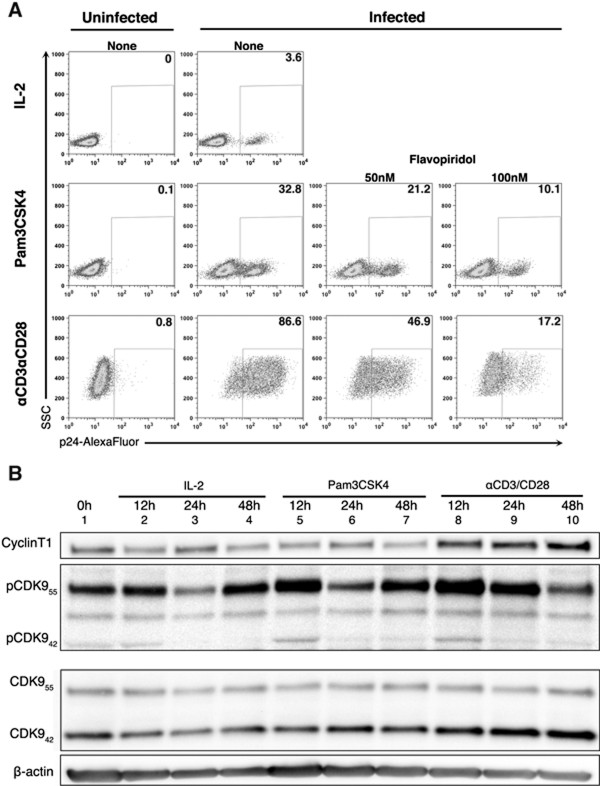
Pam3CSK4 induces viral reactivation in a Tat-dependent manner. (A) Cultured TCM cells were infected with wild-type DHIV and treated with Pam3CSK4 or stimulated with αCD3/αCD28 in the presence of 50 nM and 100 nM of Flavopiridol and assessed for intracellular p24 Gag expression by flow cytometry. Data is representative of two donors. (B) Culture TCM were either left unstimulated (0 h) or stimulated with IL-2, Pam3CSK4 and αCD3/αCD28 for 12 h, 24 h or 48 h. Whole cell extracts were isolated as indicated in the experimental procedure section. Proteins were loaded on a SDS-polyacrylamide gel, transferred to a membrane and western-blotted against CyclinT1, phospho-CDK9, CDK9, and β-actin. Data is representative of two donors.